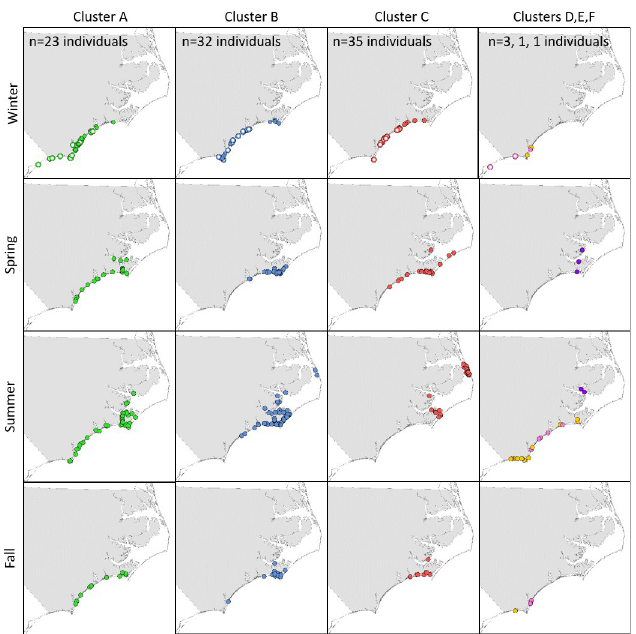
Fig 6. Seasonal distribution of social clusters of estuarine-resident common bottlenose dolphins. The seasonal distribution of all sightings of individual estuarine-resident common bottlenose dolphins ( Tursiops truncatus ) in North Carolina for each of the six clusters identified from the social network analysis. Sightings during the current survey are represented by open circles. Cluster D–yellow circles, Cluster E–purple circles, Cluster F–pink circles.